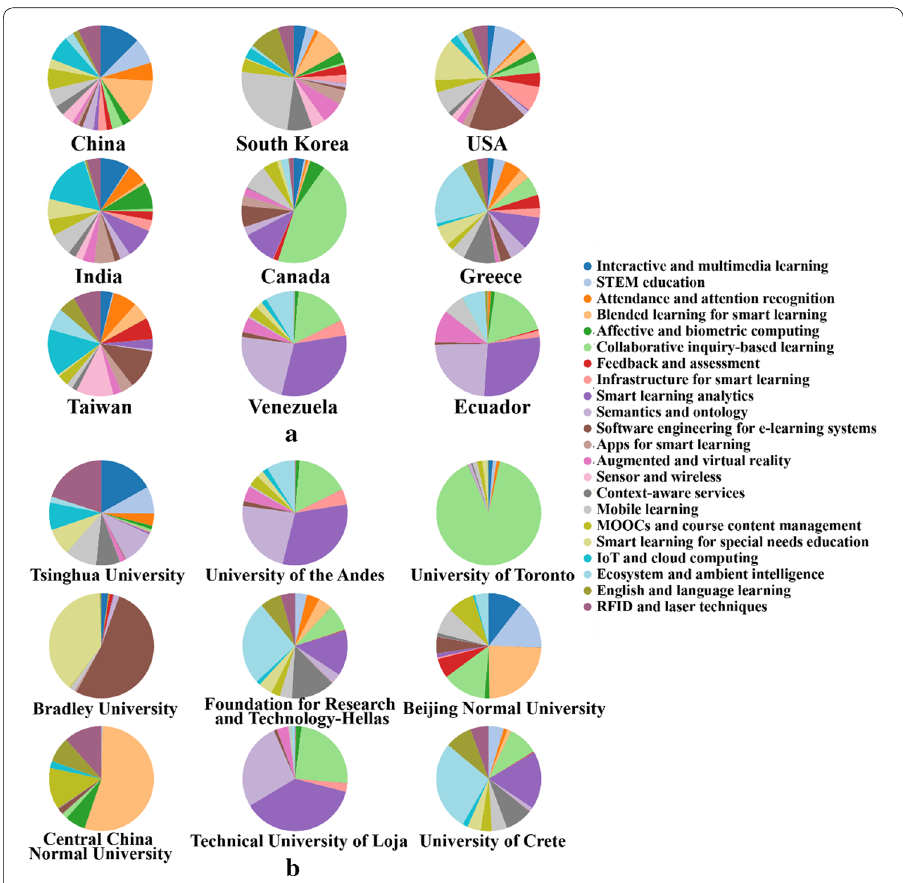
Fig. 9 Topic distributions of prolific countries/regions and